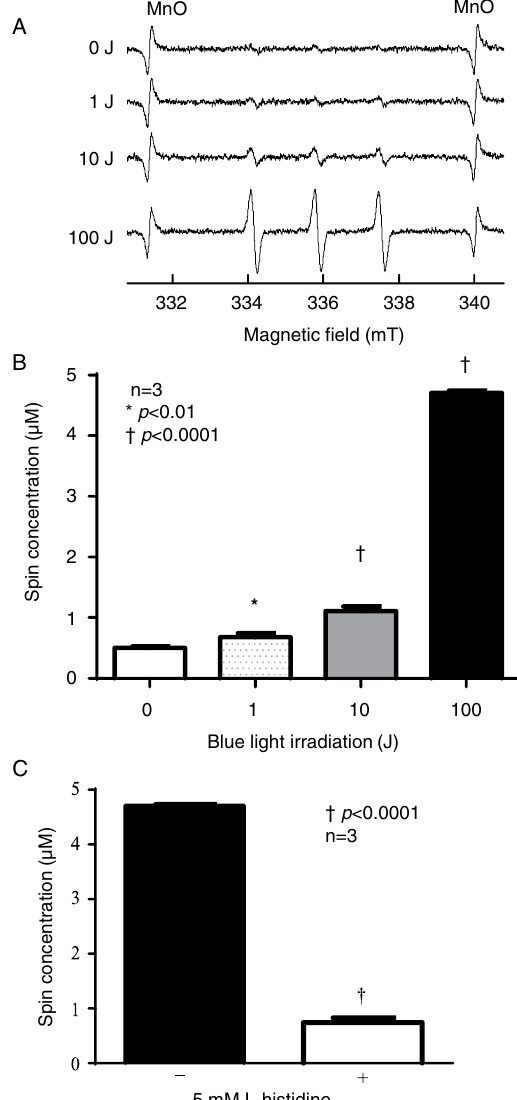
Figure 2. Singlet oxygen generation induced by PpIX upon blue light irradiation. ( A ) Typical in vitro ESR spectrum induced by PpIX upon blue light irradiation. ( B ) The concentration of generated singlet oxygen. ( C ) Generation of singlet oxygen with and without L-histidine at 100J of irradiation. The data are expressed as means ± SD (n = 3). Significant differences are expressed with * for p < 0.01 and † for p <